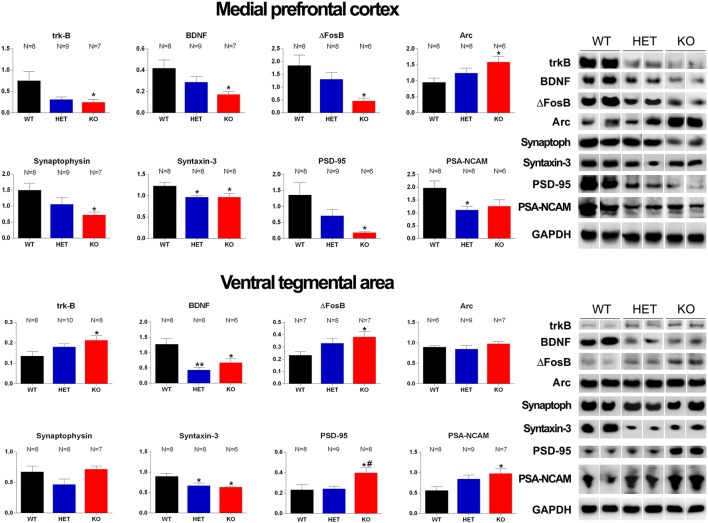
Western Blot analysis of trkB, BDNF, Δ-FosB, Arc, synaptophysin, syntaxin-3, PSD-95 and PSA-NCAM in the mPFC and VTA of WT, HET and DAT KO rats after the microdialysis experiment. Histograms on the left are the densitometric analyses of the marker/GAPDH band gray optical density (O.D.) ratios. Blot lines on the right are representative samples of two animals from each experimental group. Values are means ± SEM of the values obtained by the reported number of rats per group. *P < 0.05, **P < 0.01 with respect to WT rats; #P < 0.05 DAT KO with respect to HET rats (one-way ANOVA followed by Tukey’s pairwise comparisons).